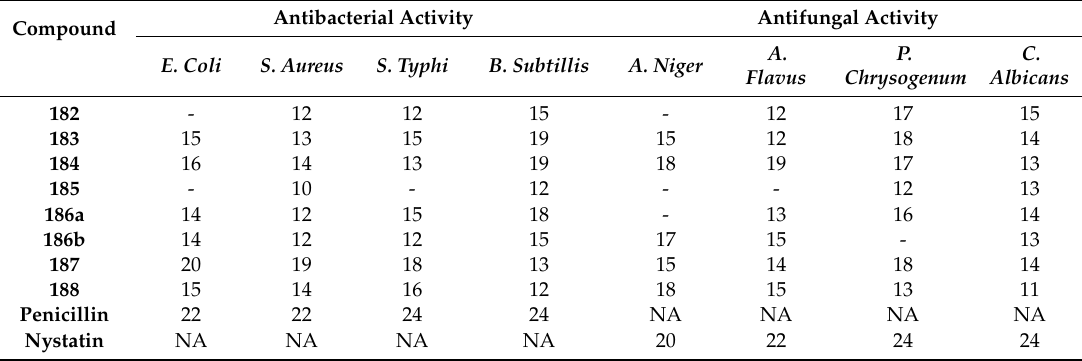
Table 27. Antimicrobial activity of 182 – 188 against Escherichia coli, Staphylococcus aureus, Salmonella typhi, Bacillus subtillis, Aspergillus niger, Aspergillus flavus, Penicillium chrysogenum, and Candida albicans strains, expressed as the zone of inhibition in mm.